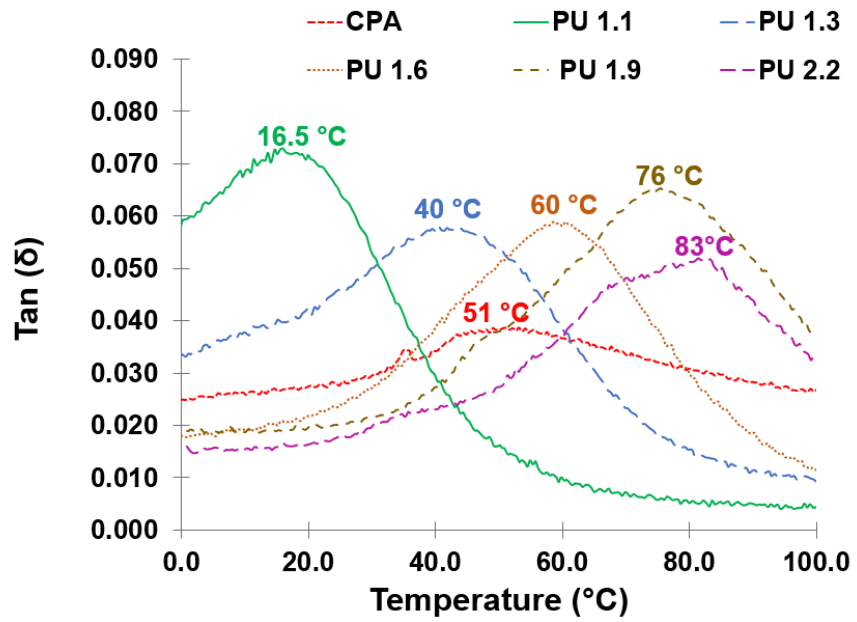
Figure 5. DMA results of lignin-based PU adhesives with different NCO/OH ratios (PU1.1 to PU 2.2) and CPA obtained at frequency 1 Hz.